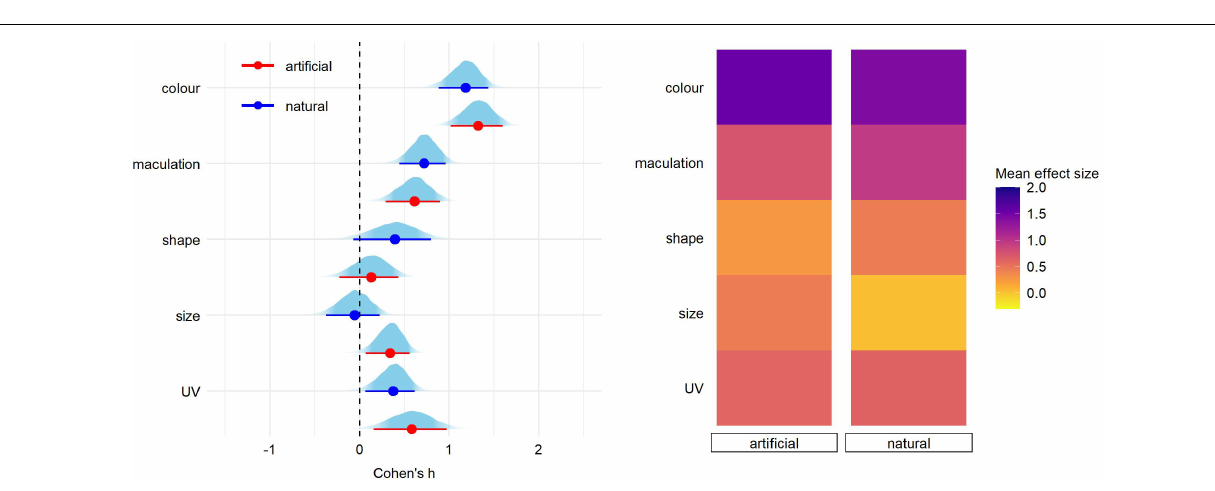
FIGURE 2 | Predicted effect size for egg trait types according to the experimental egg stimuli (natural or model egg). On the left, for each trait type we show the parameter distribution with its median (dot) and 89% credible interval (lines). On the right, the median effect sizes are plotted as a heatmap for each trait type separated by egg type